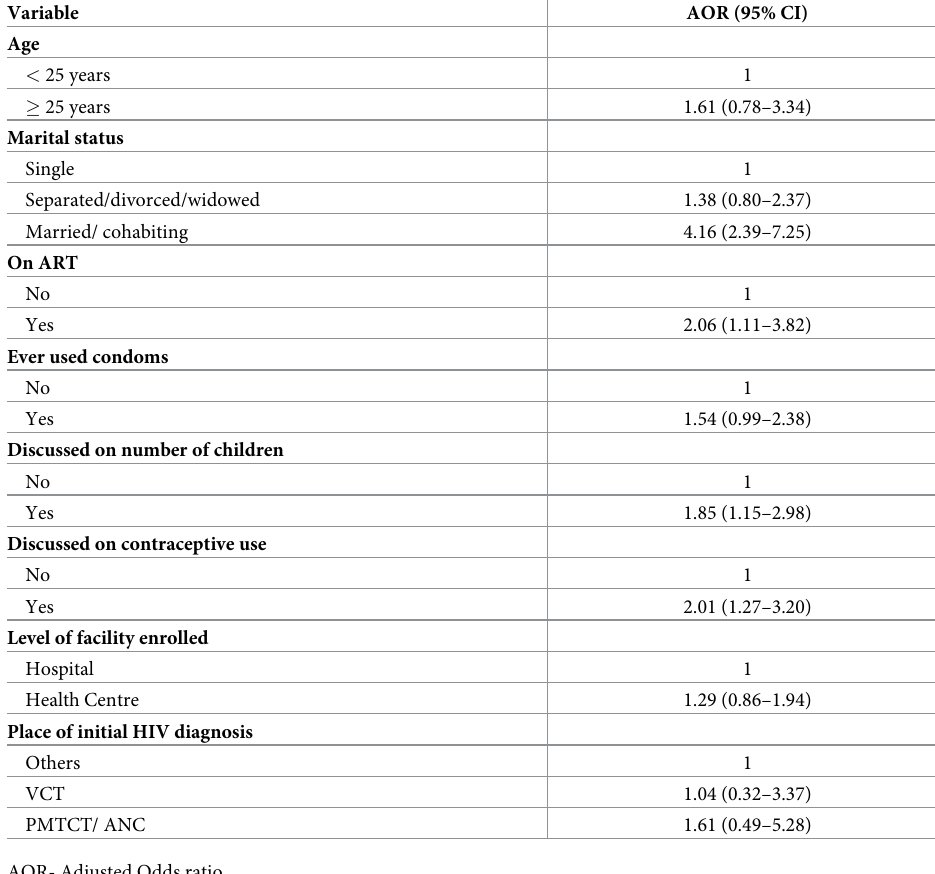
Table 4. Factors independently associated with HIV status disclosure among partners in